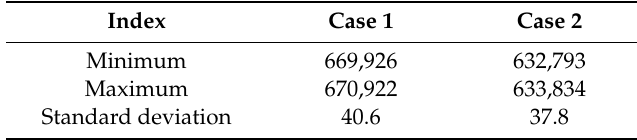
Table 3. Statistics from 1000 times of MILP-PSO